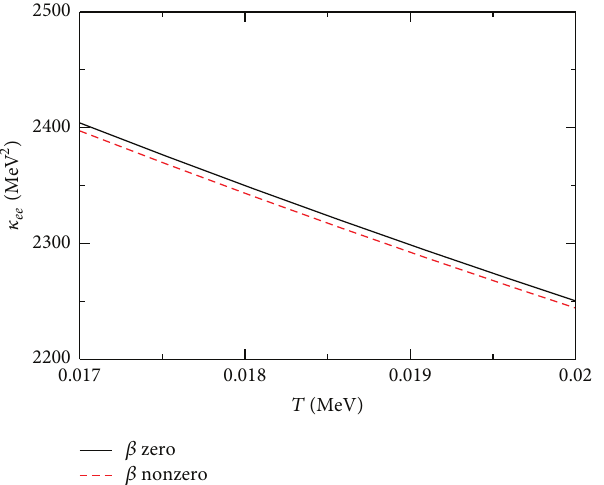
with the inclusion of 𝛽 𝑒𝑒